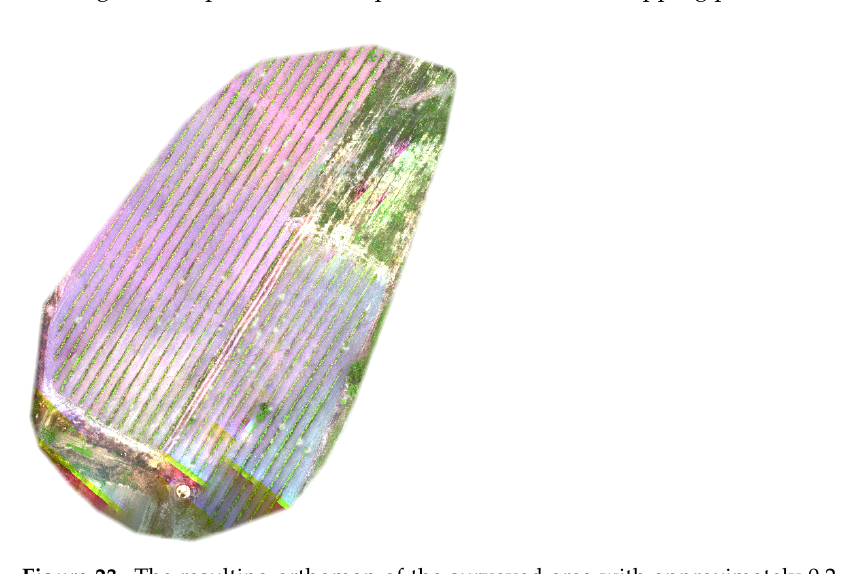
Figure 23. The resulting orthomap of the surveyed area with approximately 0.2 m between two consecutive points of the point cloud.